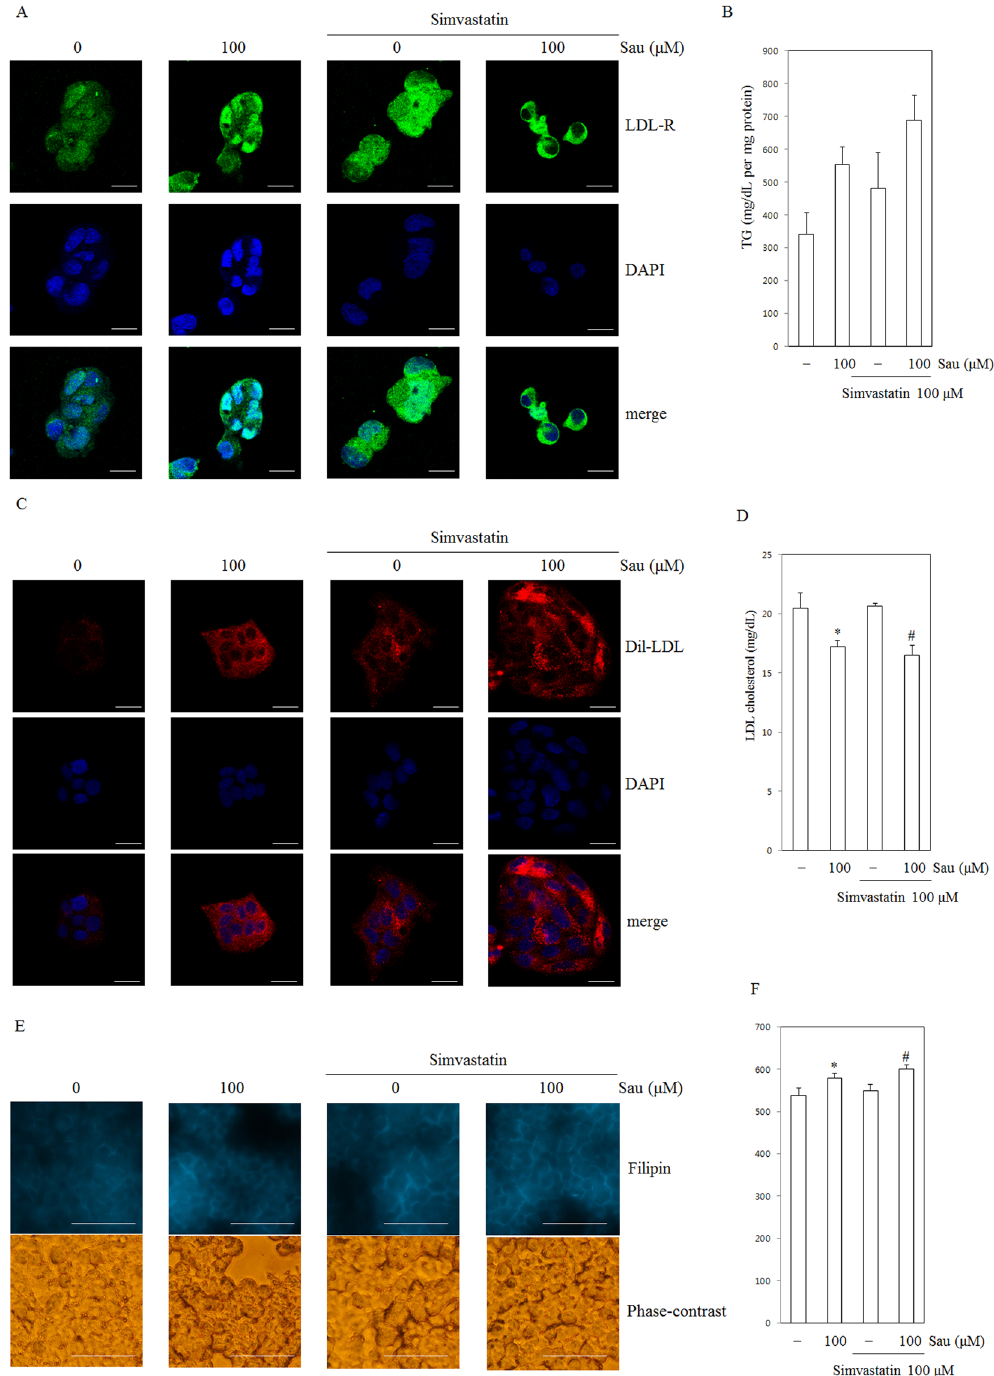
Figure 5. Effect of sauchinone on LDLR expression and cholesterol uptake in the HepG2 human hepatocellular liver carcinoma cell line. ( A ) Expression of LDLR by sauchinone. Cells were cultured for 24 hours, fixed, permeabilized, and incubated with a rabbit monoclonal anti- LDLR antibody followed by an Alexa 488 conjugated anti-rabbit IgG (green). The nuclei of the corresponding cells were visualized by 4 ′ ,6-diamidino-2-phenylindole (DAPI) staining (blue). Sau, sauchinone (magnification: × 60, scale bars: 20 µ m). ( B ) Quantification of TG in HepG2 cell lysate by ELISA kit (Cell Biolabs, Inc., San Diego, CA, USA) revealed higher uptakes of cholesterol in HepG2 cell lines. ( C ) Effect of sauchinone on intracellular accumulation of 3,3 ′ -dioctadecylindocarbocyanine-low density lipoprotein (DiI-LDL) in HepG2 cells incubated with DiI-LDL (10 μ g/mL) under control conditions or treated with 100 μ M sauchinone or simvastatin. Representative images are shown. Sau, sauchinone (magnification: × 60, scale bars: 20 µ m). ( D ) Quantification of remaining LDL cholesterol in media by ELISA kit (Cell Biolabs, Inc., San Diego, CA, USA) revealed higher uptakes of cholesterol in HepG2 cell lines. ( E ) Filipin staining of HepG2 cells cultured for 24 hours in cells treated with sauchinone (100 μ M) and simvastatin (100 μ M) as indicated. After 24 hours, cells were washed, fixed in paraformaldehyde and stained with filipin. Intracellular